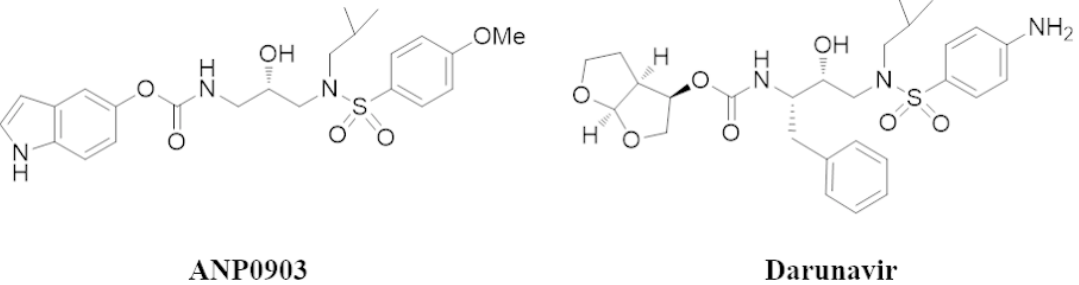
Figure 1. Chemical structures of ANP0903 and darunavir.